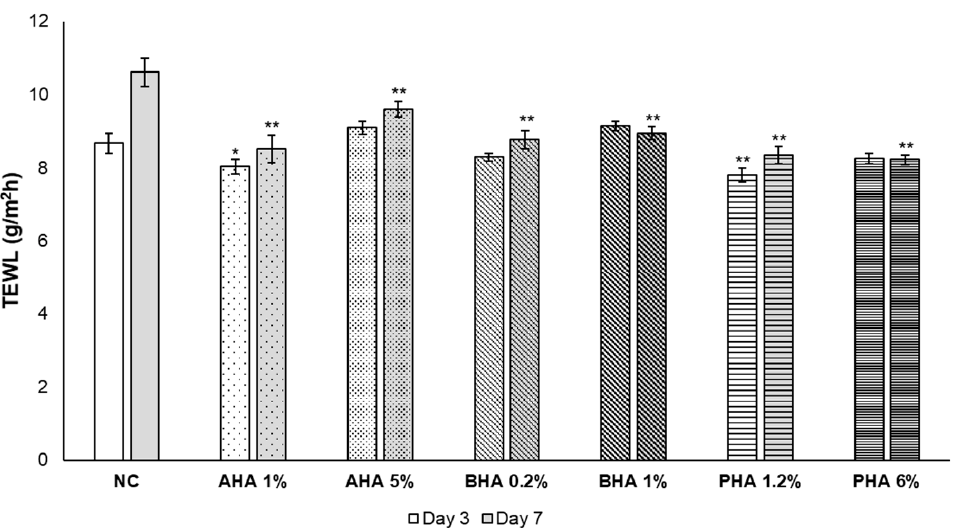
Figure 5. Effect of hydroxyacids on skin barrier function. Measurement using a vapometer with a closed chamber. Measurements were consecutively repeated three times for each skin biopsy. The mean of the three measurements was used as a representative value. Significant differences are denoted by * p < 0.05 and ** p < 0.01.